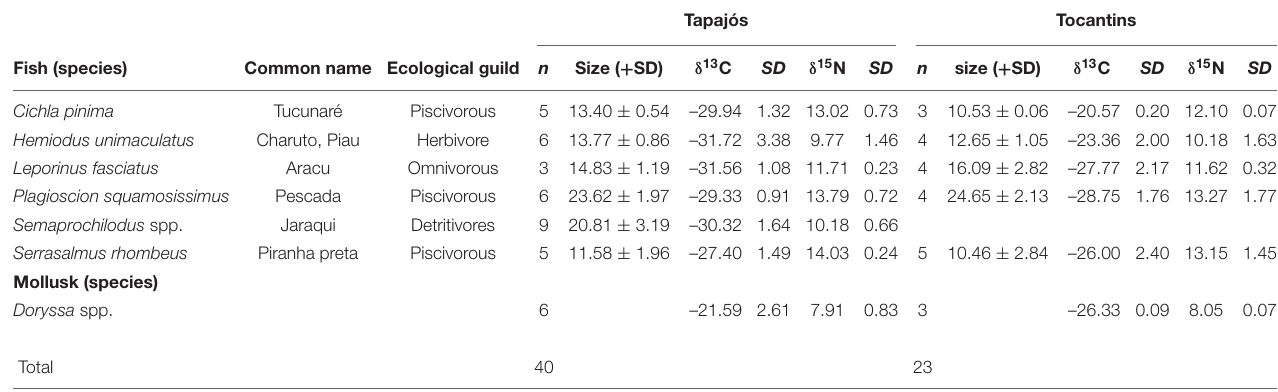
TABLE 1 | Mean and standard deviation (SD) of size (total length), number of samples (n) and values of stable isotopes of carbon ( δ 13 C) and nitrogen ( δ 15 N) of fish and mollusks sampled in the Tapajós and Tocantins rivers. Tapajós